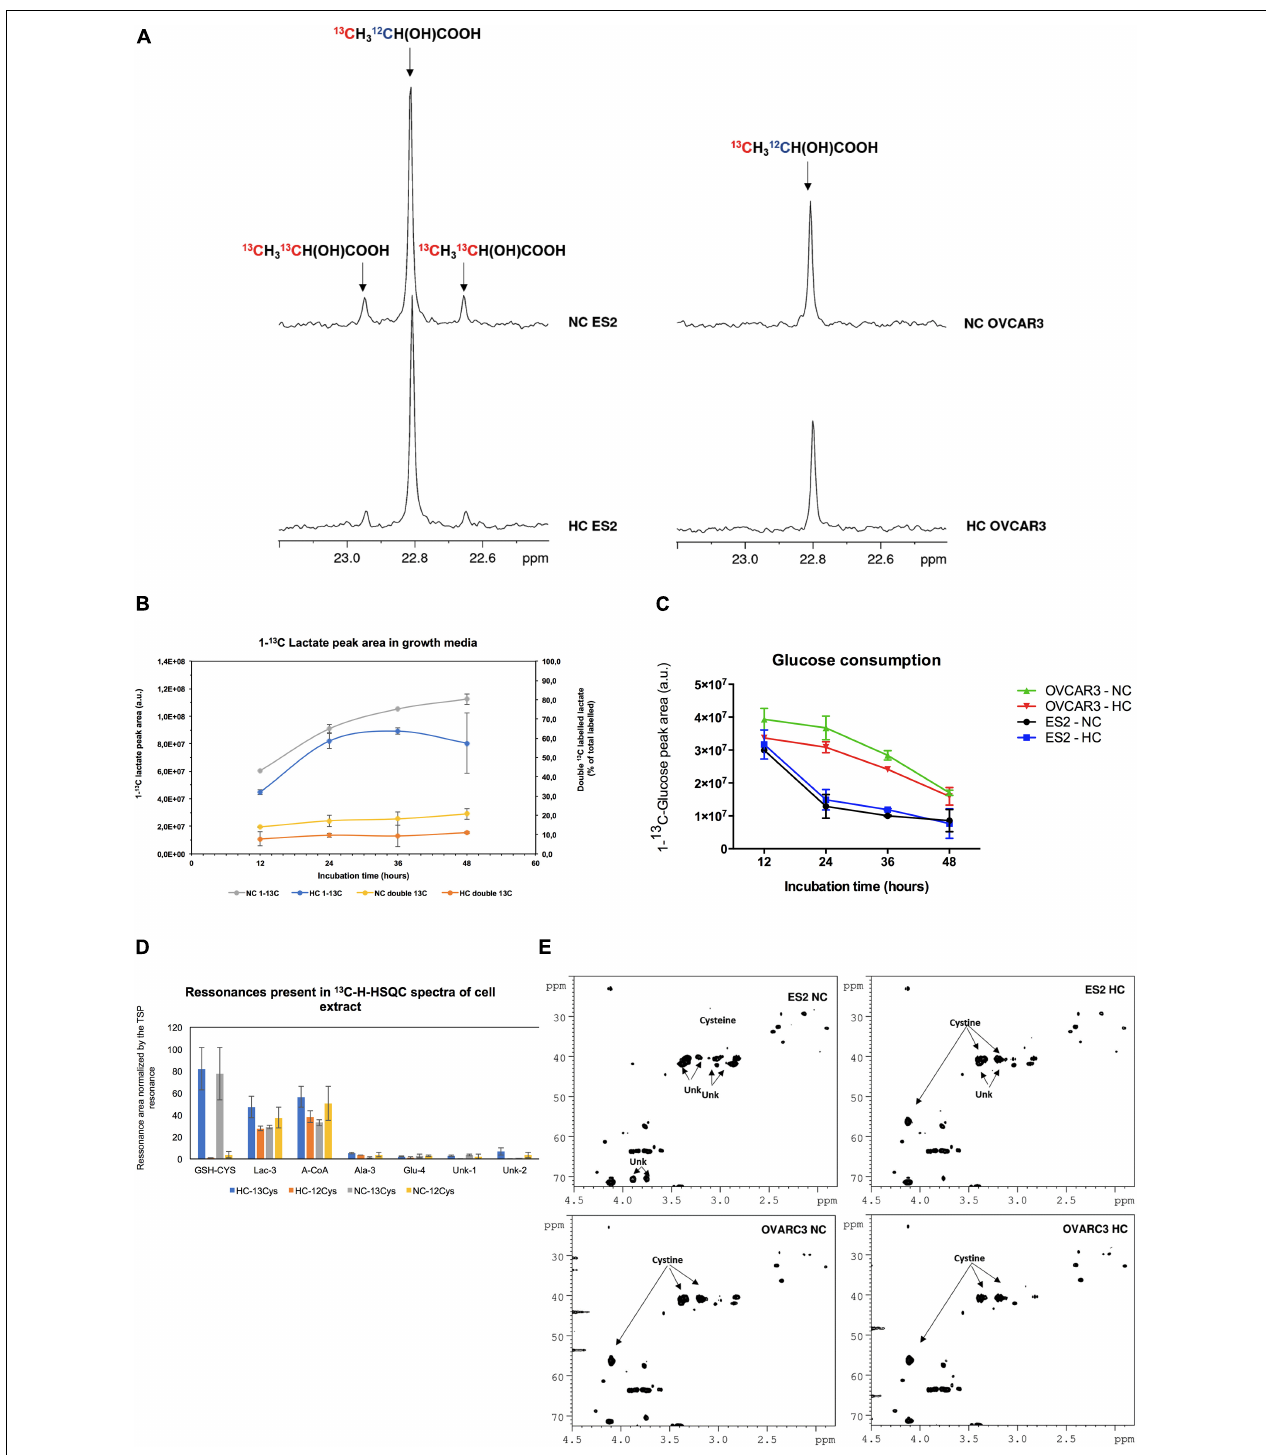
FIGURE 6 | Cysteine is directly used by ES2 cells in the main metabolic pathways. (A) Highlight of the lactate methyl group resonance on the 13 C-NMR spectra of 48 h culture media incubated with U- 13 C-cysteine. On the left panel, ES2 cells under normoxia (upper spectra) and under hypoxia (lower spectra); on the right panel, OVCAR3 cells under normoxia (upper spectra) and under hypoxia (lower spectra). (B) Production of lactate by ES2 cells in culture media at different time points (12, 24, 36, and 48 h). (C) Glucose consumption in ES2 and OVCAR3 cells. (D) Resonances areas of the 13 C-1H-HSQC projection on 13 C spectra normalized by TSP area in the cell extracts. (E) Highlight of 13 C-1H-HSQC spectra of the growth media at 48 h incubation in the presence of U- 13 C-cysteine under normoxia and hypoxia conditions. NC, normoxia with cysteine; HC, hypoxia with cysteine. (B–D) Results are shown as mean ± SD. Assays were performed in biological triplicates.